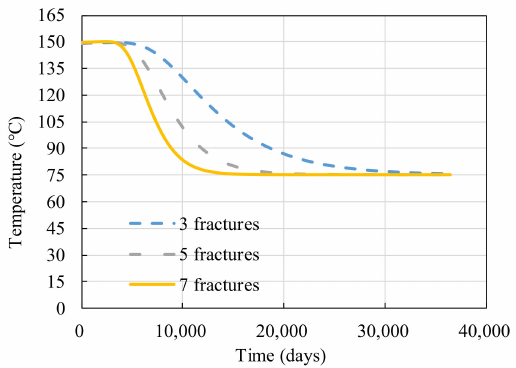
Figure 6. Effect of fracture number on thermal